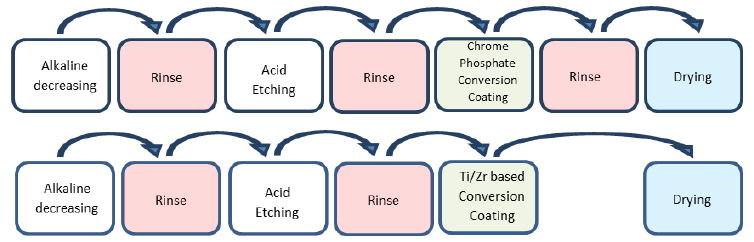
Figure 2. Comparison of steps for rinse and no-rinse processes.